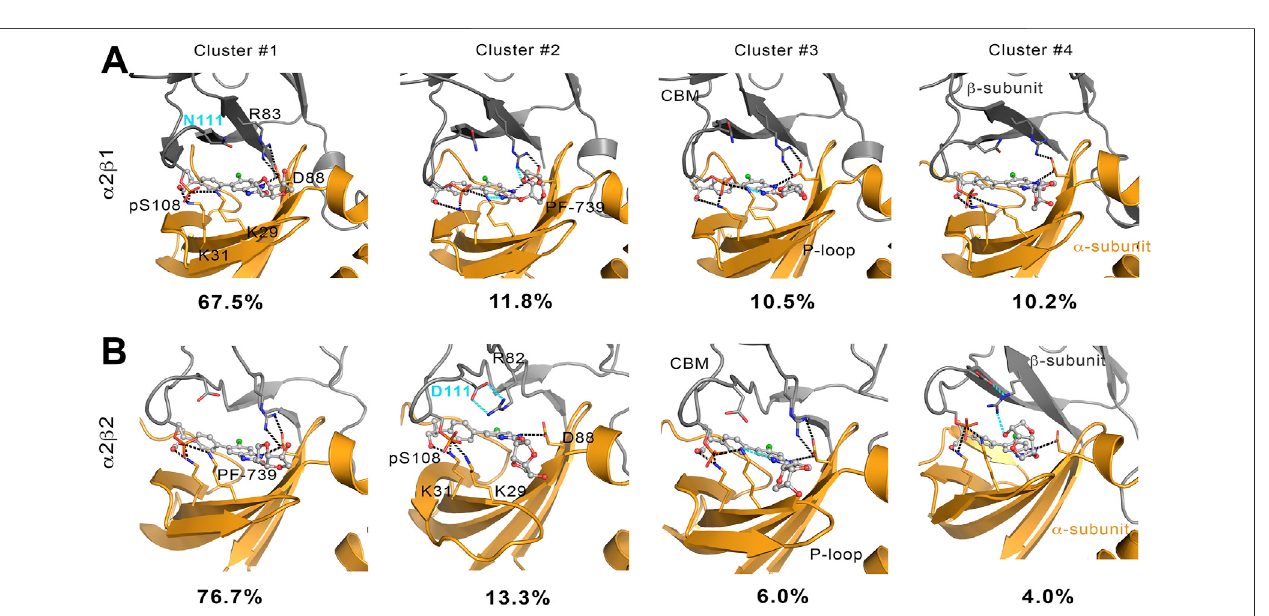
Frontiers in Molecular Biosciences |